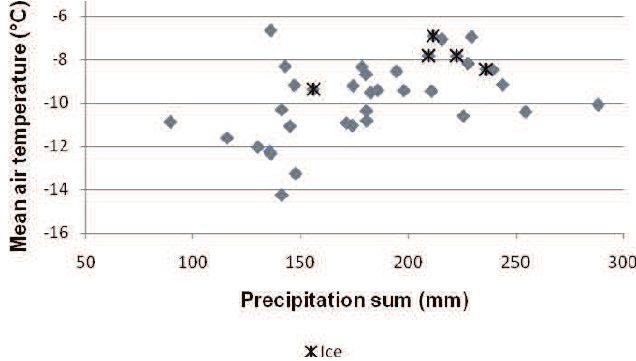
Figure 6. The measured annual mean air temperature during winter in relation to the corresponding mean precipitation sum in Muonio during 1972-2010. Winters with icy conditions reported by reindeer herders marked with